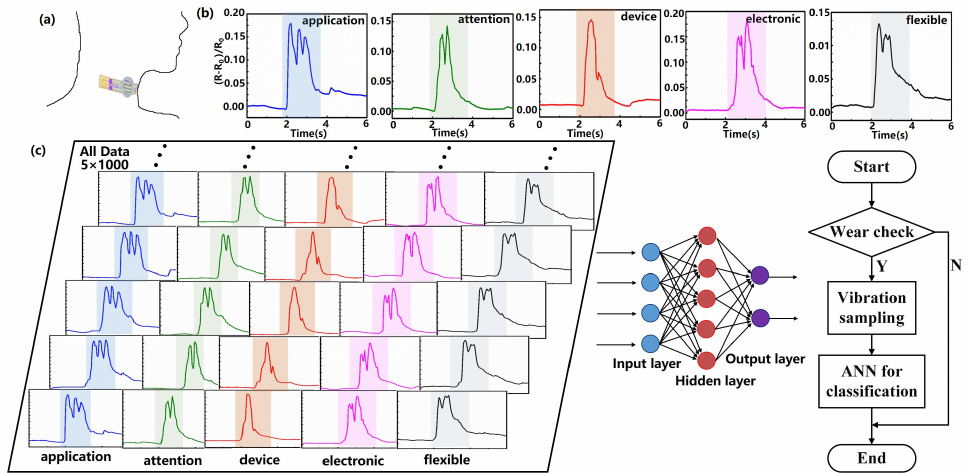
Figure 2. ( a ) Schematic diagram showing flexible pressure and temperature sensor attached to the neck skin for monitoring vocal fold vibrations during speech. ( b ) Resistance change waveforms of the fabricated device recorded for five words “application,” “attention,” “device,” “electronic,” and “flexible.” ( c ) The specific experiment flow